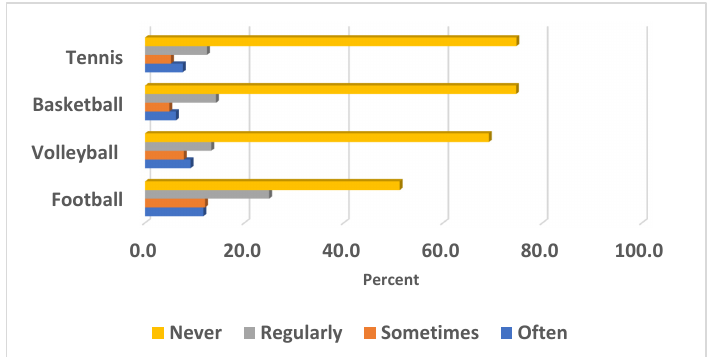
Figure 1. Sports played in school by adolescents .